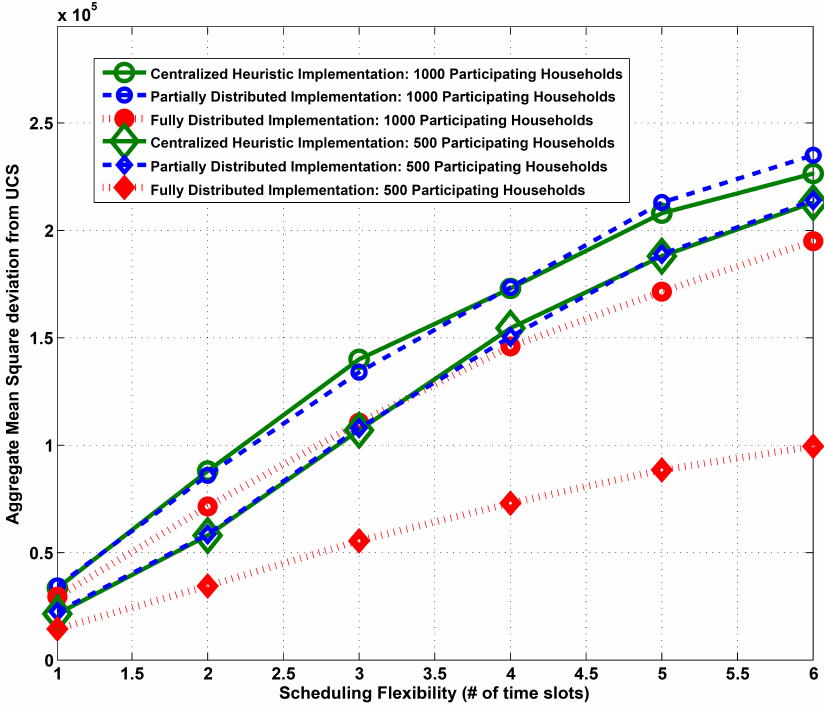
Figure 6. Aggregate mean square deviation from UCS vs . scheduling flexibility: different participation rate of